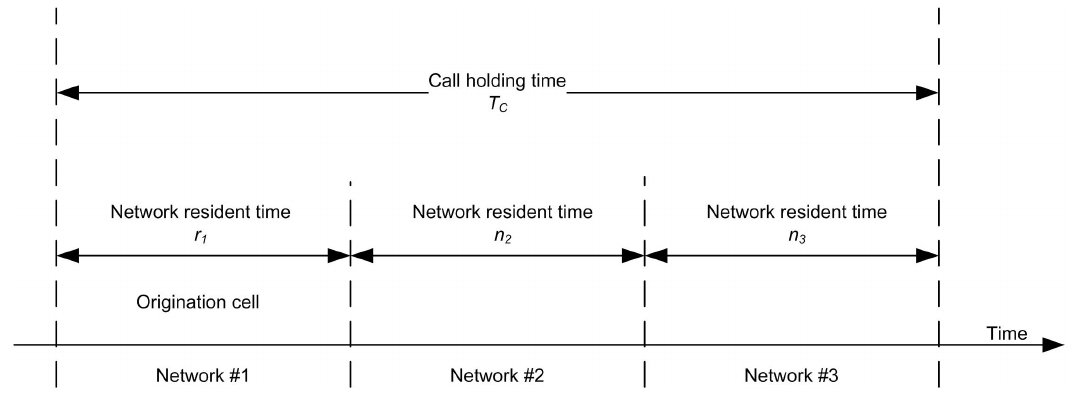
Figure 8. Timing diagram for network residence time and call holding